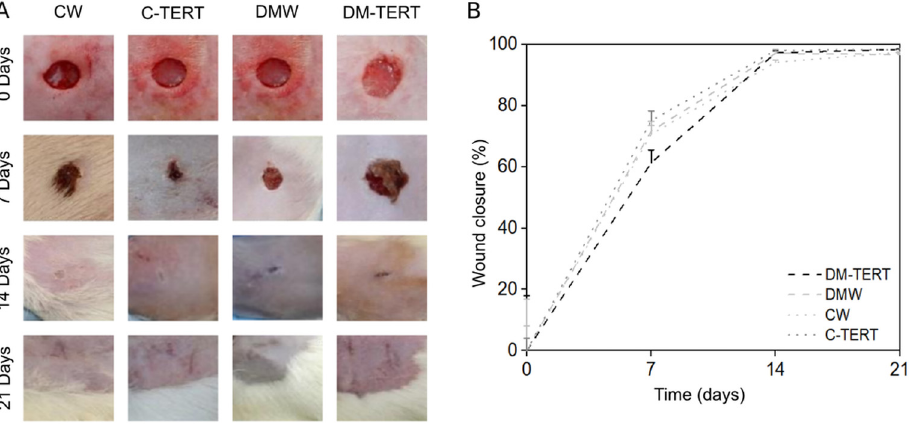
Figure 3. Effects of human bone marrow mesenchymal cells immortalized by the expression of telomerase (hMSC-TERT) infusion on wound closure. A , Representative images of wounds in rats from the groups evaluated on days 0, 7, 14, and 21. B , Percentage of wound reduction in the healing area on days 0, 7, 14, and 21 post-injury. The data are reported as means ± SD. CW: control rats wounded; C-TERT: non-diabetic rats wounded and infused with hBMSC-TERT; DMW: diabetic rats wounded; DM-TERT: diabetic rats wounded and infused with